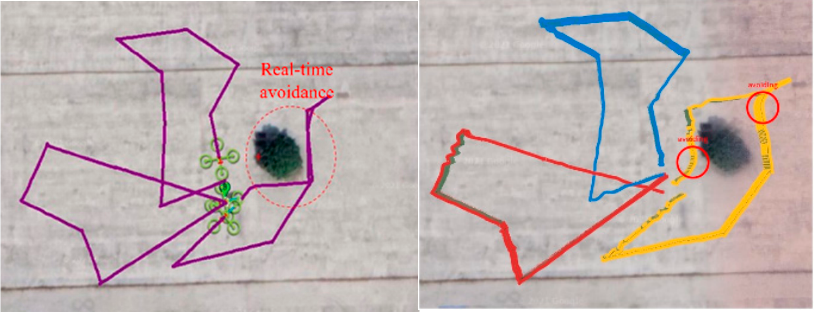
Figure 26. Multi-UAVs dynamic avoidance simulation ( left ) and real flight test trajectory ( right ).